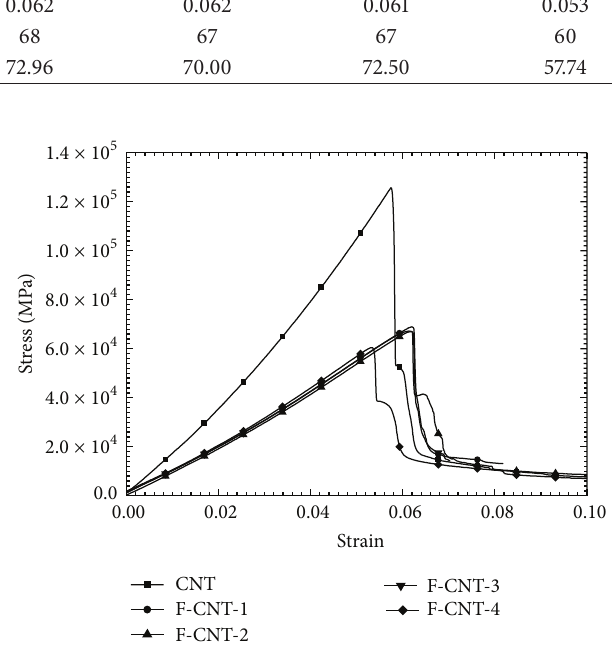
Figure 7: Variation of compression stress versus strain of CNTs with different functionalization configurations.